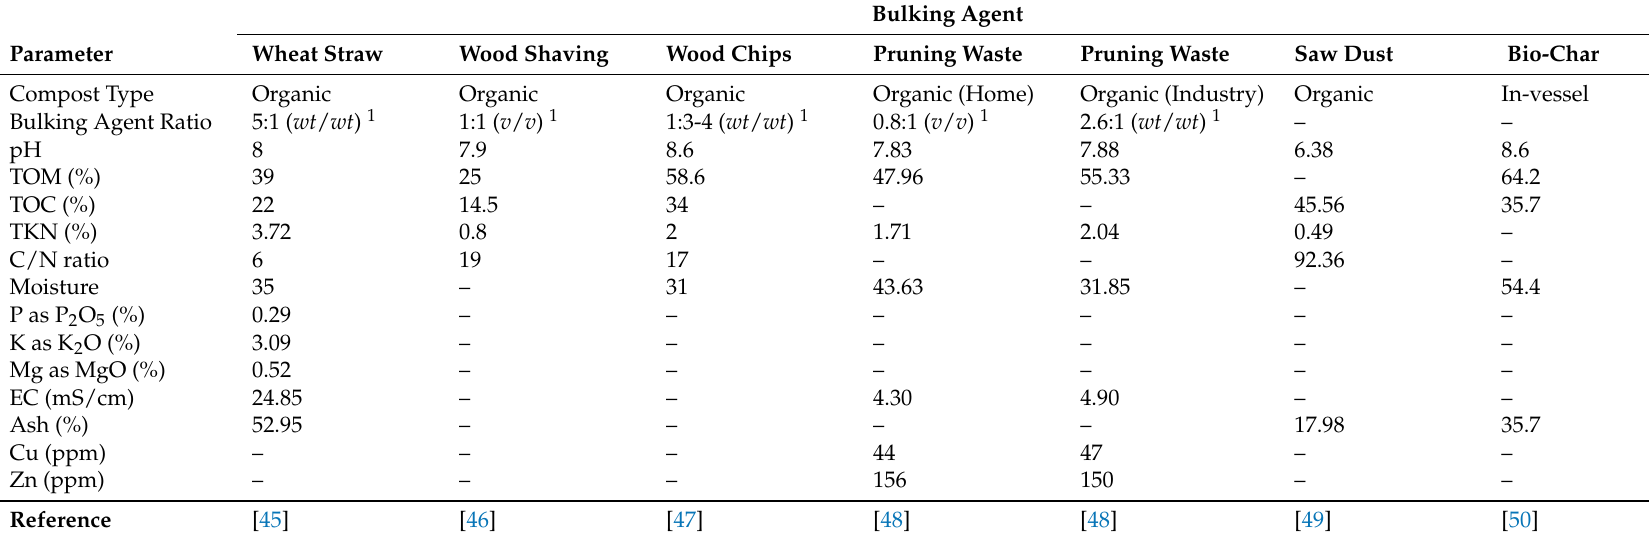
Table 4. Physicochemical properties of several mature composts produced using varying bulking